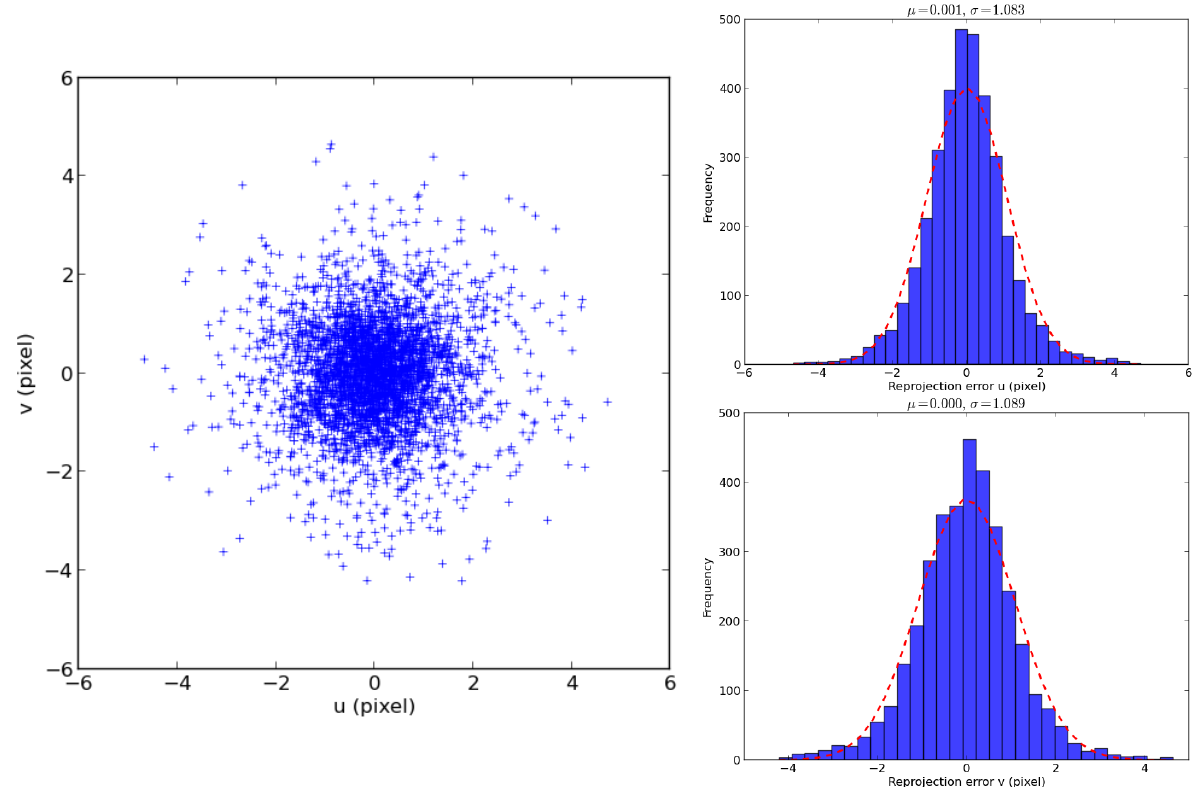
Figure 18. Re-projection error of the features after the refinement step of Camera